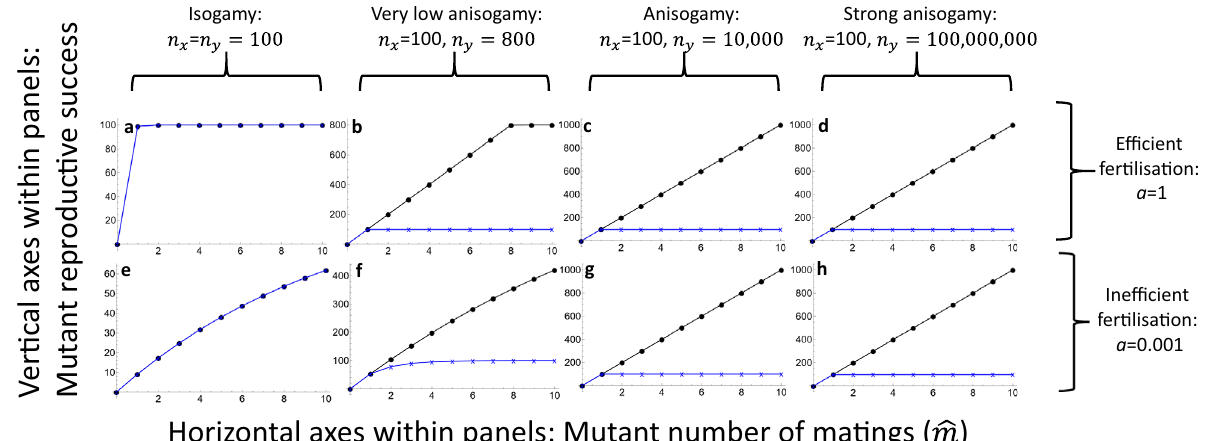
Fig. 1 The Bateman function of Eq. (1). This fi gure shows how the basic Bateman gradient asymmetry arises from simple biophysics and mathematics of fertilisation. The population is monogamous aside from a mutant individual, whose number of fertilisation partners ( ‘ matings ’ ) varies on the horizontal axes within panels. a – d show the effect of variation in sex-speci fi c gamete numbers under ef fi cient fertilisation, while e – h show the effect of variation in sex- speci fi c gamete numbers under inef fi cient fertilisation. Parameter values used are shown in the fi gure. Females (gamete number n x ) are indicated by blue crosses and connecting lines, while males (gamete number n y ) are indicated by black dots and connecting lines. Under isogamy, females and males are unde fi ned, and the two colours overlap. The typical sex-speci fi c shapes of Bateman gradients arise from a single equation (which itself is not sex-speci fi c) when a difference in gamete numbers is assigned to n x and n y , con fi rming Bateman ’ s intuition that the primary cause of the difference in selection is that females produce fewer gametes than males. The entire range of gamete number ratios presented in the fi gure is observed in nature, from equal gamete size in many unicellular organisms 39 to vertebrates, where sperm count per ejaculate can commonly exceed 10 9 (see ref. 40 and Supplementary Information